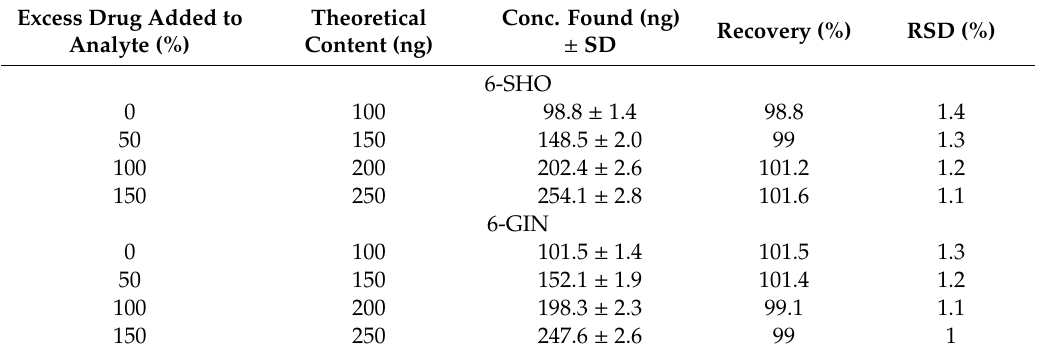
Table 2. Accuracy data of 6-SHO and 6-GIN for the green RP-HPTLC method (mean ± SD; n = 6). Excess Drug Added